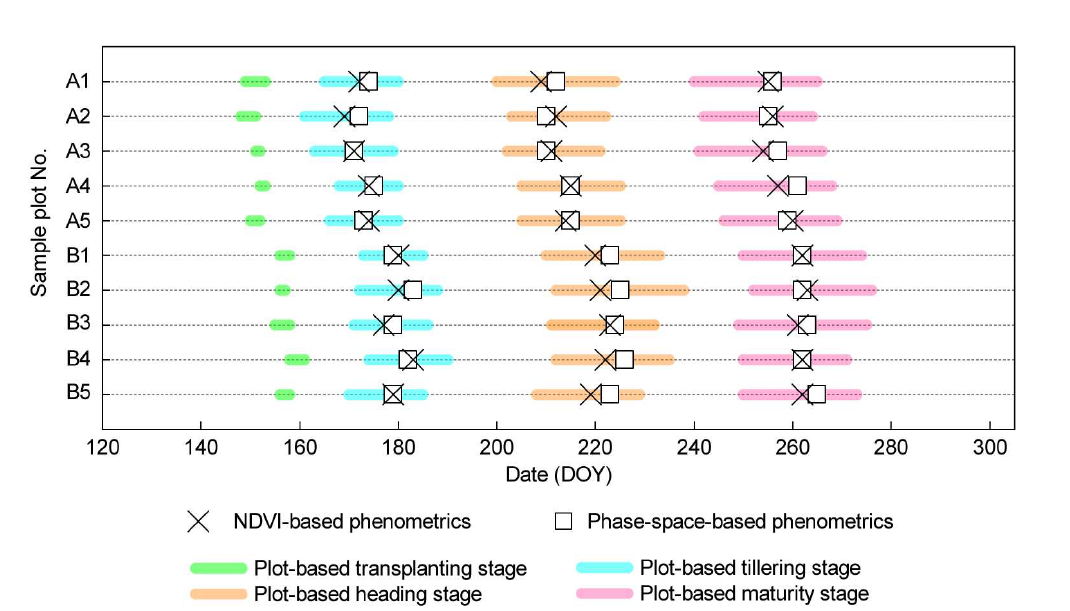
Figure 5. Comparison between satellite-derived rice phenometrics and plot-based rice growth stages for Site A and B in 2014. The satellite-derived phenometrics include the dates of active tillering ( D til ), middle heading ( D head ), and maturity ( D mat ), from left to right, derived from NDVI and phase–space, respectively. The rice phenological stages from the 10 sample plots were acquired from the in-situ investigations. The end of the maturity stage represents the harvesting